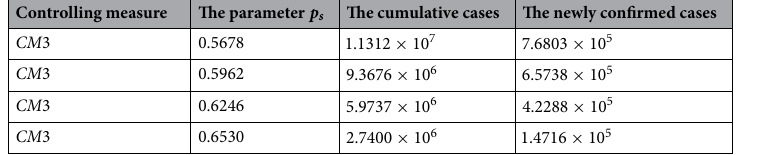
Controlling measure